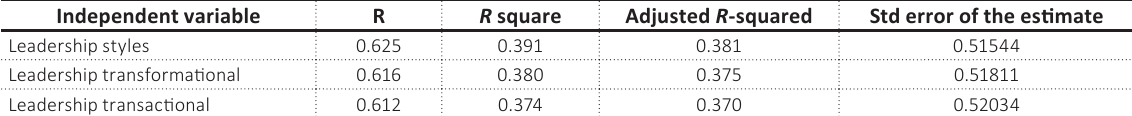
Table 7. Model summary